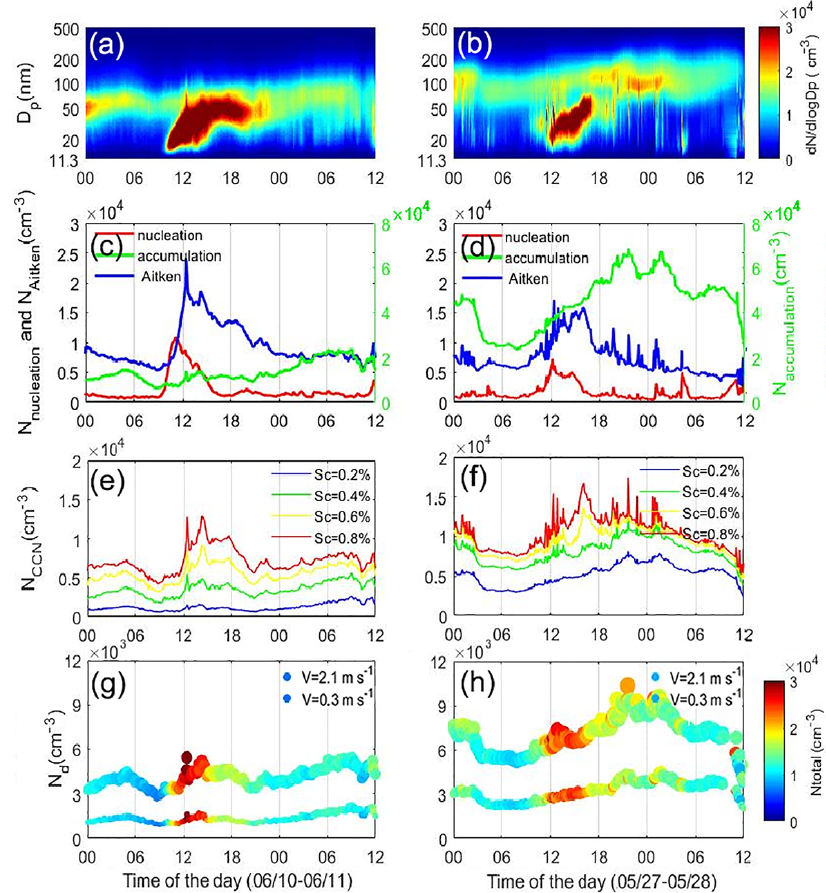
Figure 6. Comparison of (a, b) the particle number size distribution PNSD, (c, d) aerosol particle number concentration N CN , (e, f) CCN number concentration N CCN and (g, h) cloud droplet number concentration N d between a clean and a polluted NPF event. The clean NPF day is with a clean background (PM 2 . 5 = 14 (µg/m 3 ), and the polluted NPF day is with PM 2 . 5 of 73µg/m 3 .